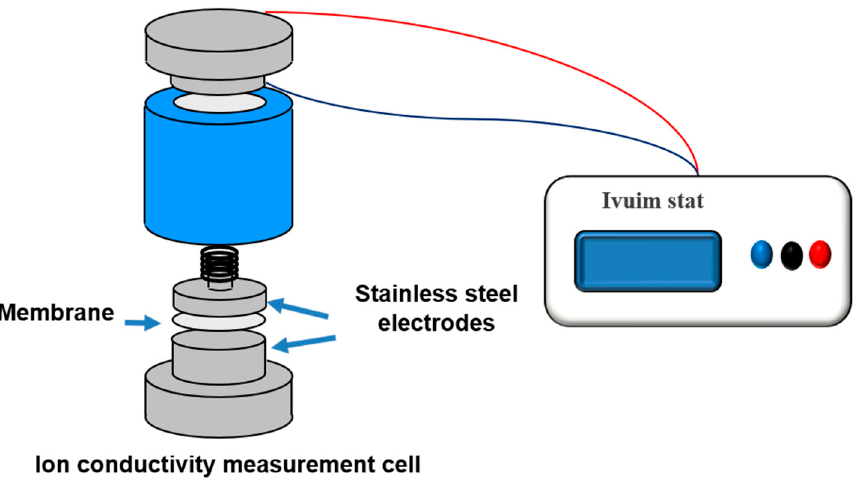
Figure 2. Experimental set-up for the ionic conductivity measurements of the different mem- branes.